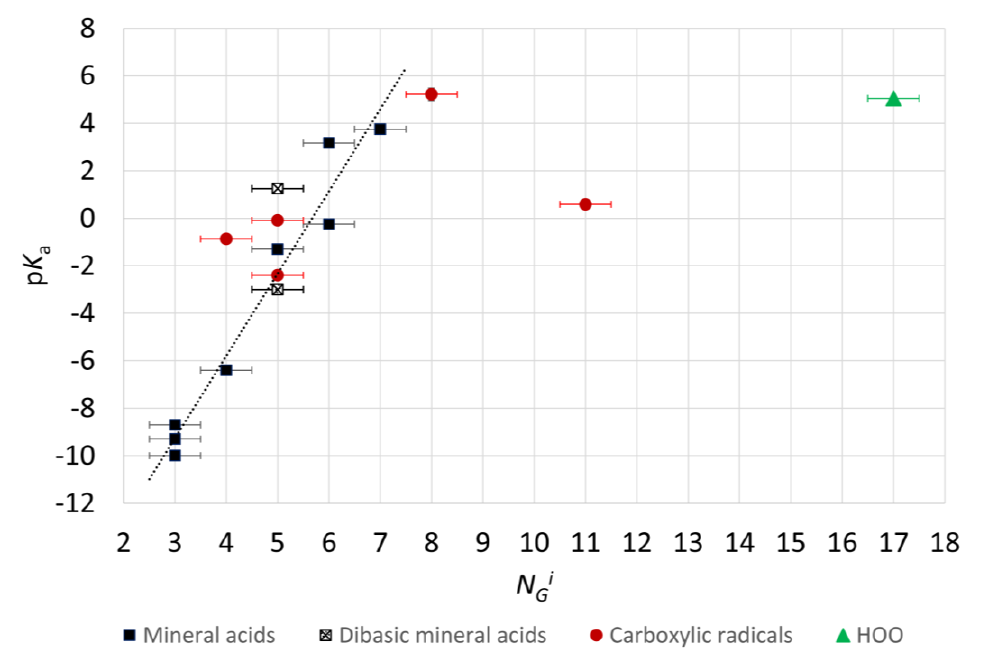
Figure 9. Plots of p K a versus the number of microsolvating water molecules needed to cause ionization.